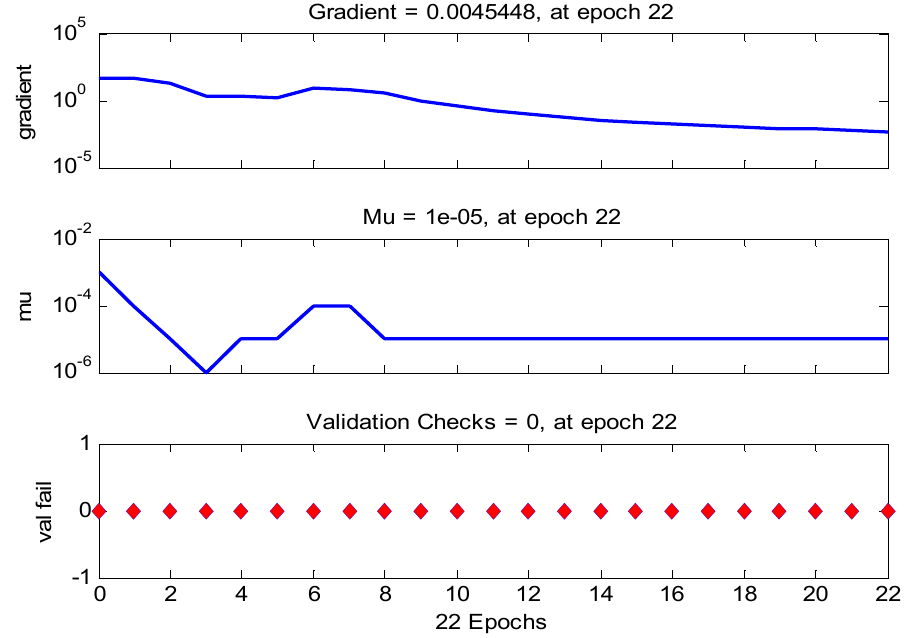
Figure A6. Neural network training performance.